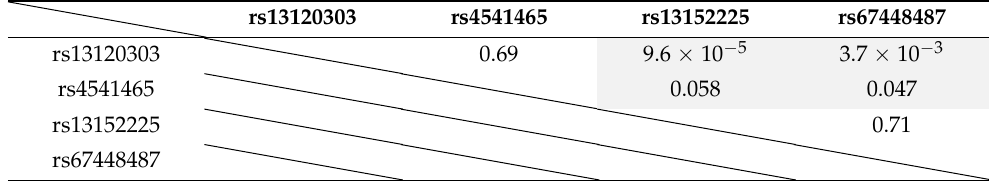
Table 1. Linkage disequilibrium patterns (r 2